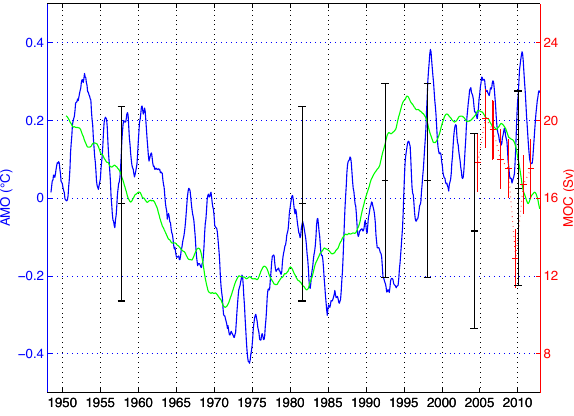
Fig. 7. Annual average estimates of the AMOC from the 26 ◦ N array (red, Sv right axis, error bar=1.5Sv), estimates of the AMOC from 6 hydrographic sections (black, Sv right axis, error bar=5Sv), the time series of annual average values of the AMO (blue, ◦ C left axis) and accumulated NAO index (green, arbitrary